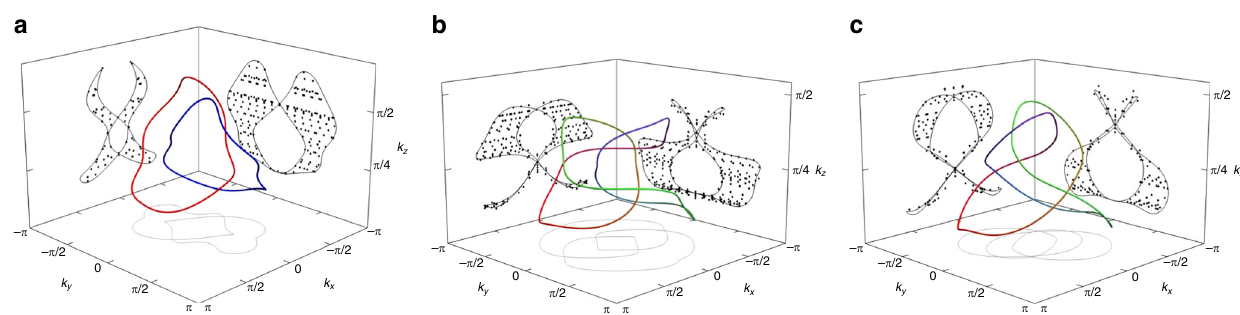
Fig. 4 Simulated drumhead state measurements under various OBCs. The black diamond-shaped points indicate points in reciprocal space with admittance eigenvalues smaller than their respectively admittance thresholds j x , j y corresponding to x , y open boundaries, as obtained from Xyce circuit simulations. These points are contained in regions of the surface BZ which are bounded by the projected 3D theoretically computed bulk nodal structures (colored green, red and blue). a shows two entangled unknots, de fi ned as the Hopf-link. The black dots combine the simulation results with circuit dimensions of 22 ´ 22 ´ 16 ð Þ . The admittance thresholds are chosen to be j x = 0.0027 Ω − 1 and j y = 0.0020 Ω − 1 . b depicts a trefoil knot showing the combined simulations of circuit system sizes of 20 ´ 20 ´ 20 ð 0.0030 Ω − 1 and j y = 0.0025 Ω − 1 . c illustrates a fi gure-8 knot with 23 ´ 23 ´ 23